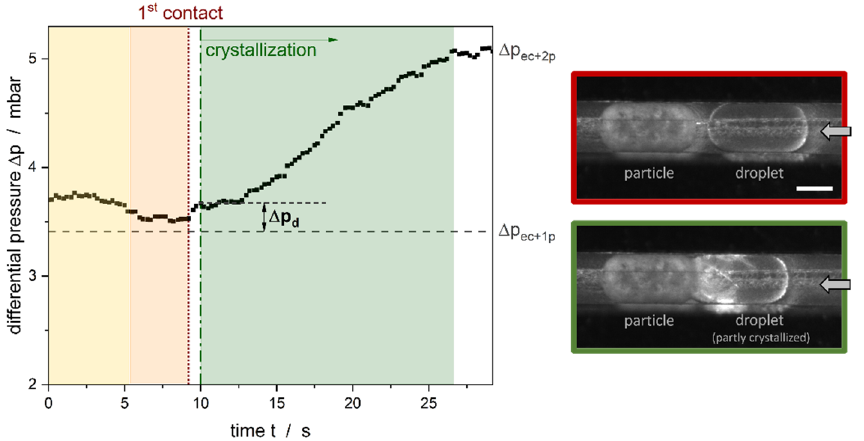
Figure 12. Exemplary measurement data for the pressure drop as a function of time during the formation of the droplet at the T-junction (yellow), the movement of the droplet along the channel (orange), the first contact of particle and droplet as well as the crystallization of the droplet (green). Δ𝑝 (cid:3032)(cid:3030)(cid:2878)(cid:2869)(cid:3043) and Δ𝑝 (cid:3032)(cid:3030)(cid:2878)(cid:2870)(cid:3043) represent the differential pressures measured for the system when one or two solid particles were circulated by the continuous phase. The two microscopic images show the droplets moving toward the solid particle (red frame) and the crystallization of the droplet after the contact with the solid particle (green frame). The white bar represents 200 µm. The arrows in the pictures indicate the flow direction of the continuous phase and, consequently, also of the subcooled droplet.